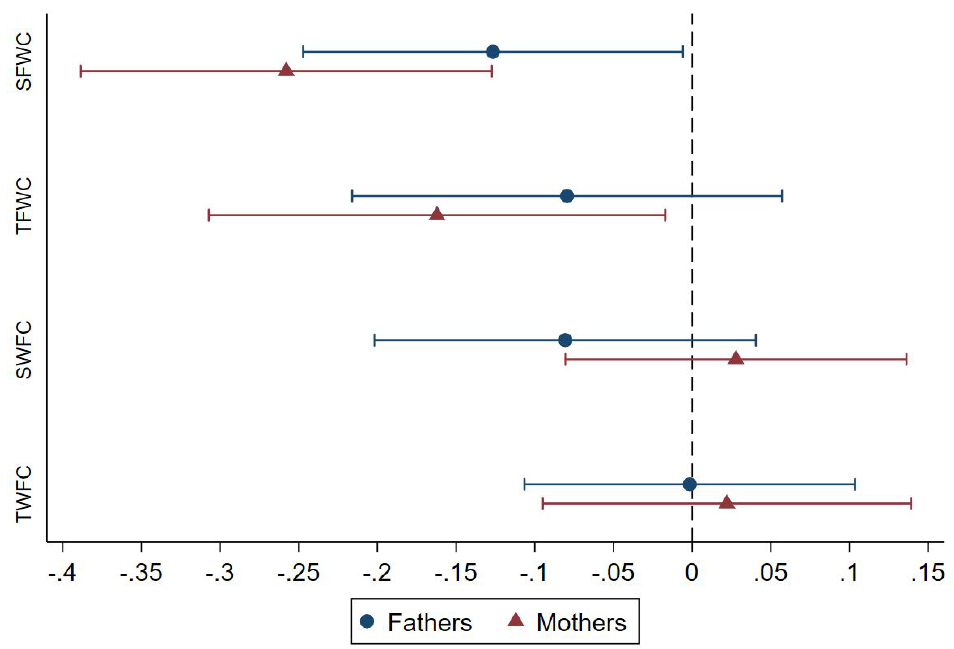
Standardized effects of partner support on strain and time-related conflicts of parents divided by